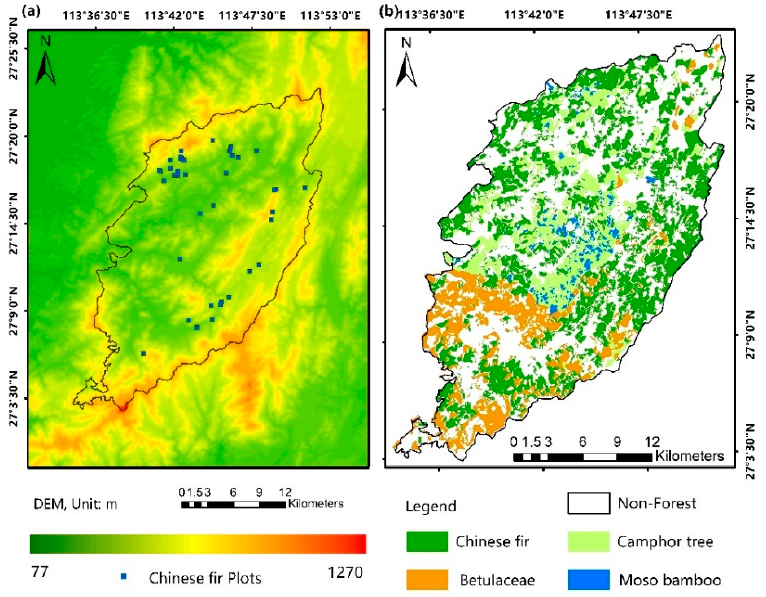
Figure 2. ( a ) The digital elevation model (DEM) of the study area and the spatial distribution of Chinese fir plots; ( b ) The distribution of tree species in the study area.